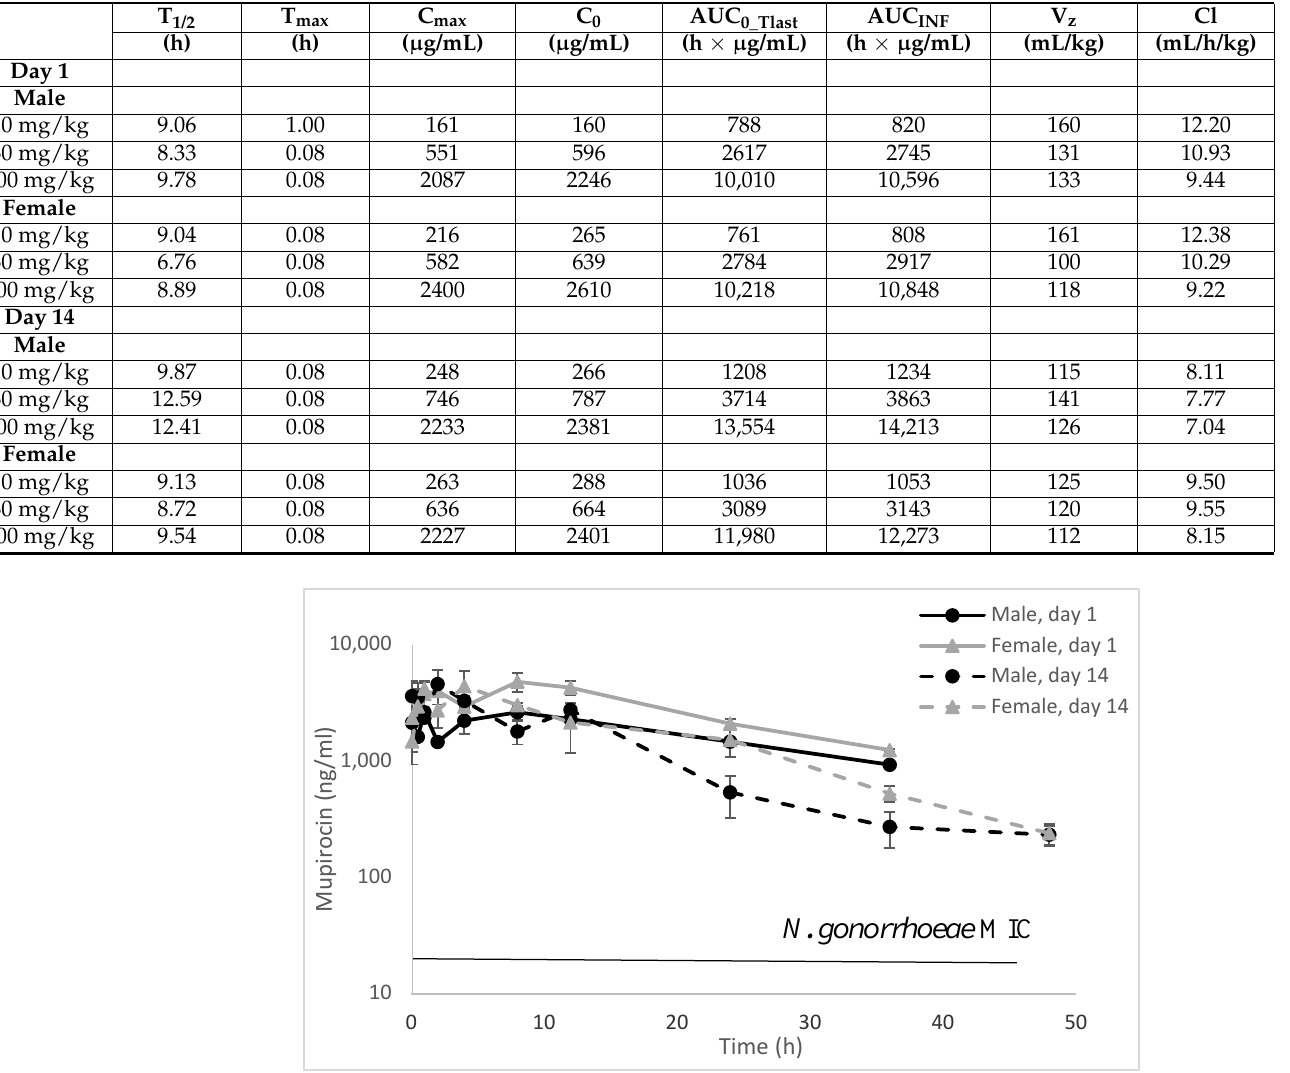
Table 6. Pharmacokinetic parameters following IV administration of 10, 30, and 100 mg/kg Nano-mupirocin to rats.